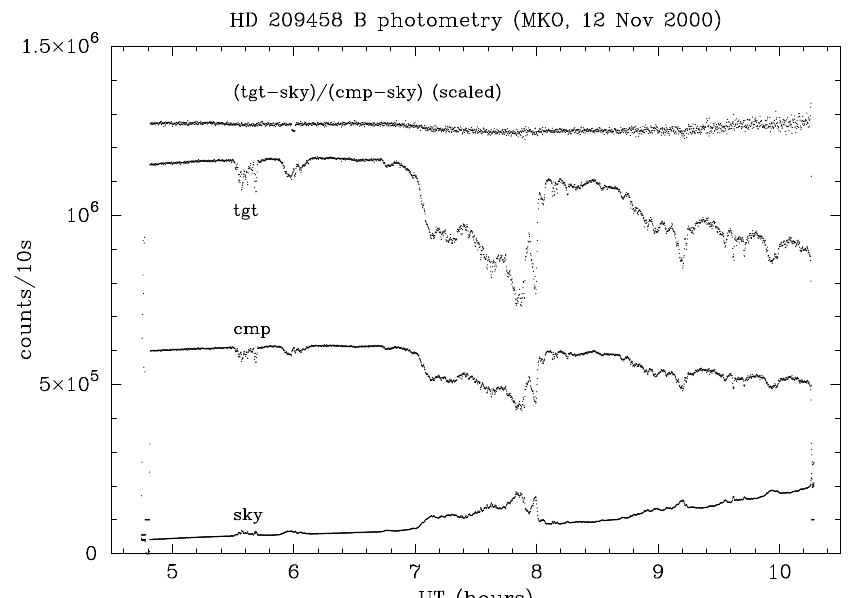
Fig. 6. Raw data for the transit observations made through cloud on 12 November 2000.